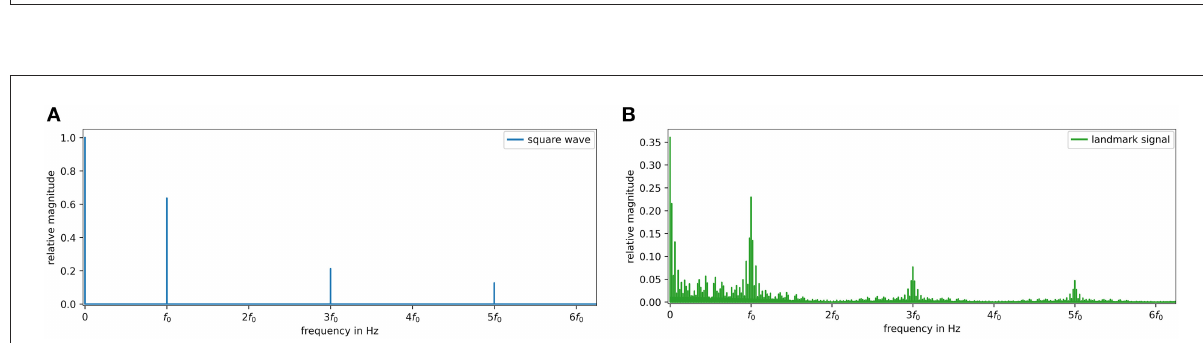
FIGURE3 Simulated, synthetic frequency spectra of an ideal, continuous square wave with f 0 of 20Hz and 50% duty cycle [ (A) , blue] and of a landmark signal with 2 . 5s intervals, 1 . 2s active period, and an incrementing 8bit data segment [ (B) , green]. In both cases, the even harmonics of f 0 are zero. For the discontinuous landmark signal, the spectrum spreads around the odd multiples of f 0 . The energy contained in the DC component at 0 as well as in f 0 and its harmonics decreases considerably (note the y